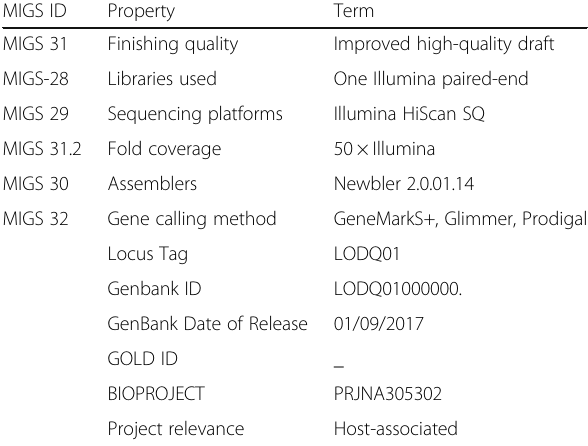
Table 2 Project